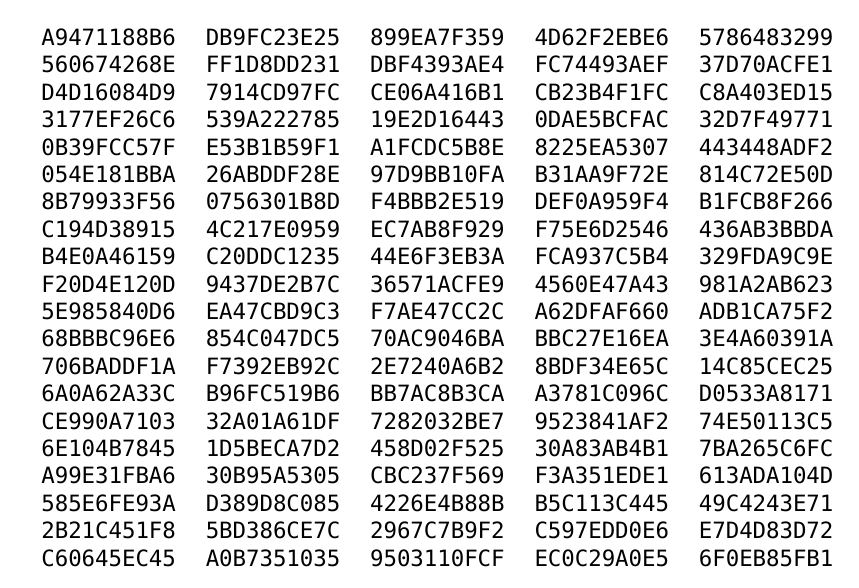
Table A1. Codes used in the designed experiment shown as hexadecimal numbers. Conversion to binary, including the possible leading zeros and replacing zeros with − 1, gives the 100 codes of 40 bits used. Codes are transmitted with the leftmost bit first. Every entry represents one 40-baud code. The first five codes are those forming the first row in the